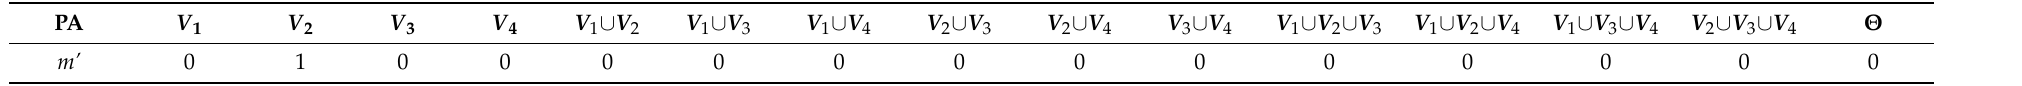
Table 20. The result of second-level fusion for an image of a longitudinal crack based on OAO classifiers.